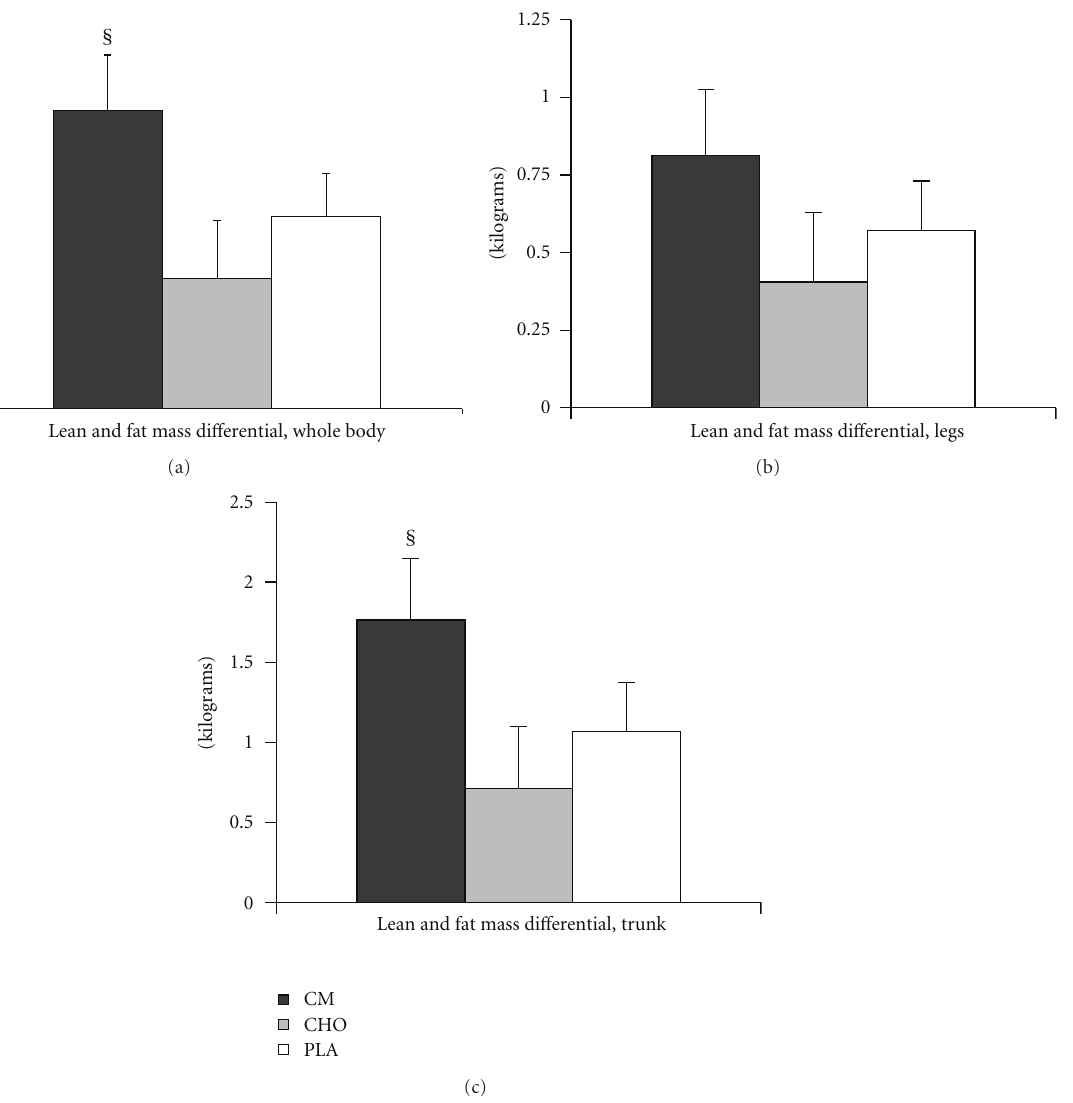
Figure 4: Body composition lean and fat mass di ff erentials. (a) Whole body di ff erential. Lean mass (kg) gained and fat mass (kg) lost was used to calculate a whole-body di ff erential to quantify overall body composition changes in response to 4.5 wks of cycling exercise training. (LM) − (FM) = di ff erential. Example: (0.900kg lean mass) − ( − 0.350kg fat mass) = 1.250kg. (b) Lean and fat mass di ff erential for the legs. (c) Lean and fat mass di ff erential for the trunk region. Values are mean ± SE. Significant treatment di ff erences: § , CM versus CHO ( P < .